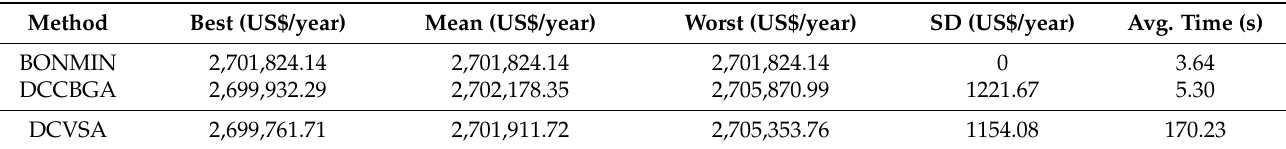
Table 3. Numerical performance comparison between the DCVSA and DCCBGA in the IEEE 33-bus system after 100 consecutive